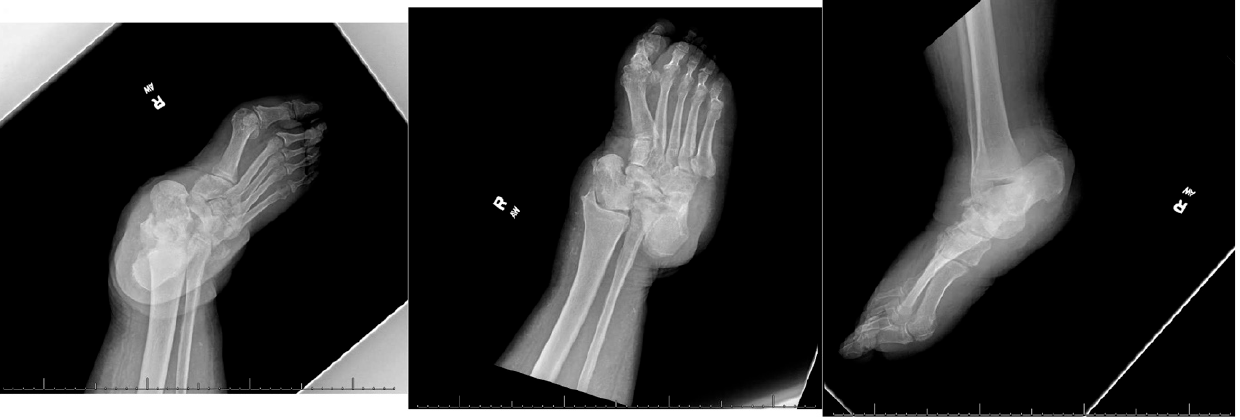
Figure 1. Preoperative radiographic images.